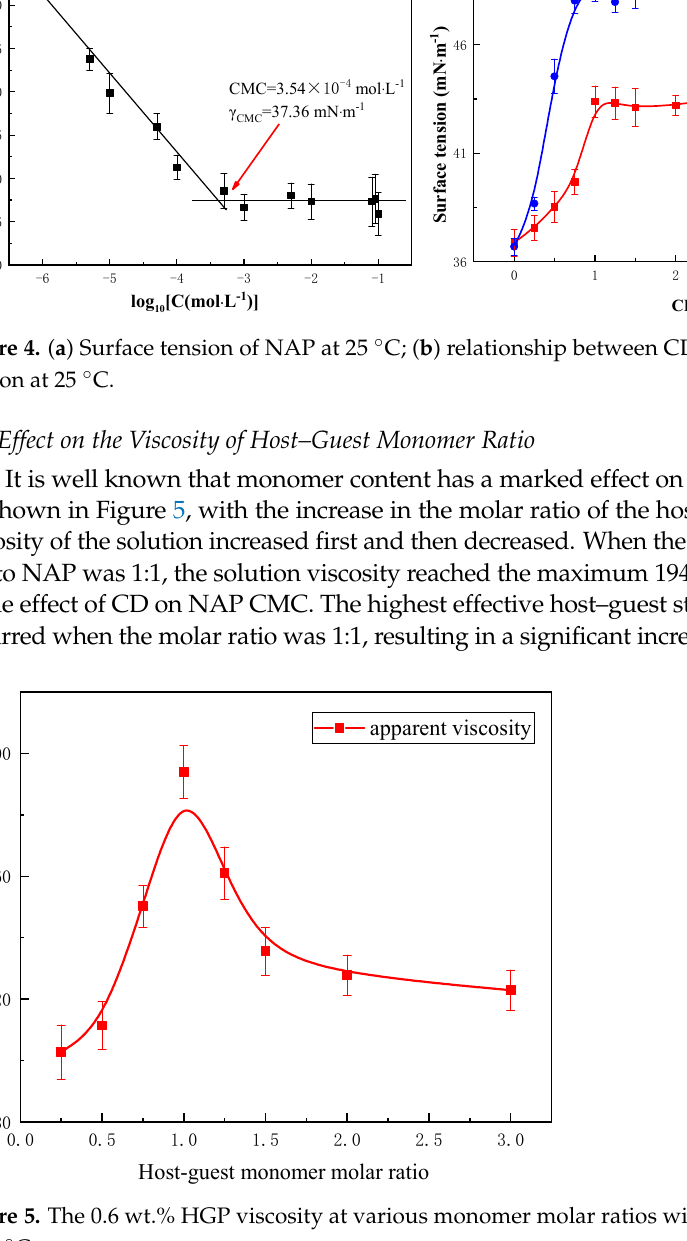
Figure 3. The FTIR spectrum of HGP.